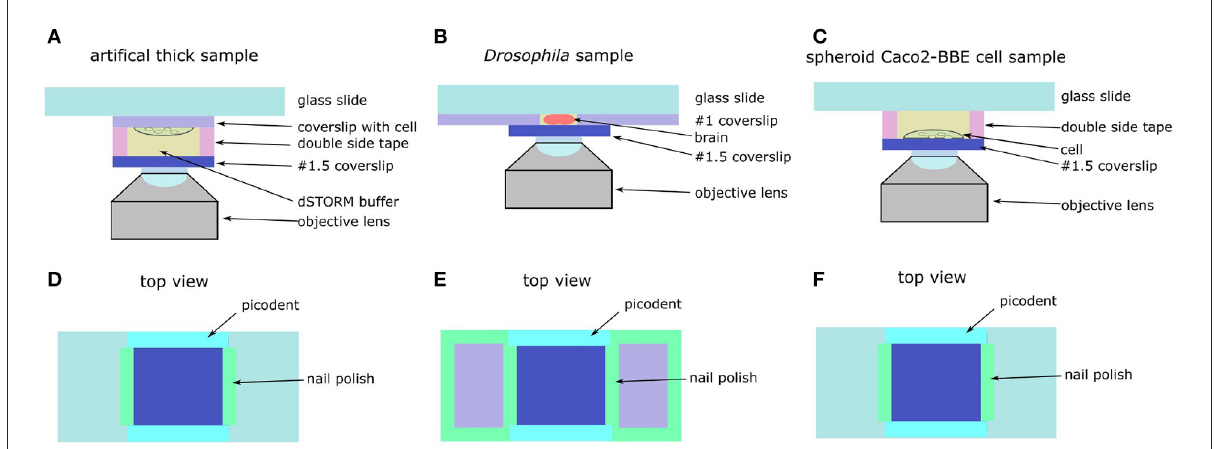
FIGURE7 schematic of artificial thick and Drosophila brain. (A) Side view of artificial thick sample. (B) Side view of Drosophila brain. (C) Side view of spheroid Caco2-BBE cell sample. (D) Top view of artificial thick sample. (E) Top view of Drosophila brain. (F) Top view of spheroid Caco2-BBE cell